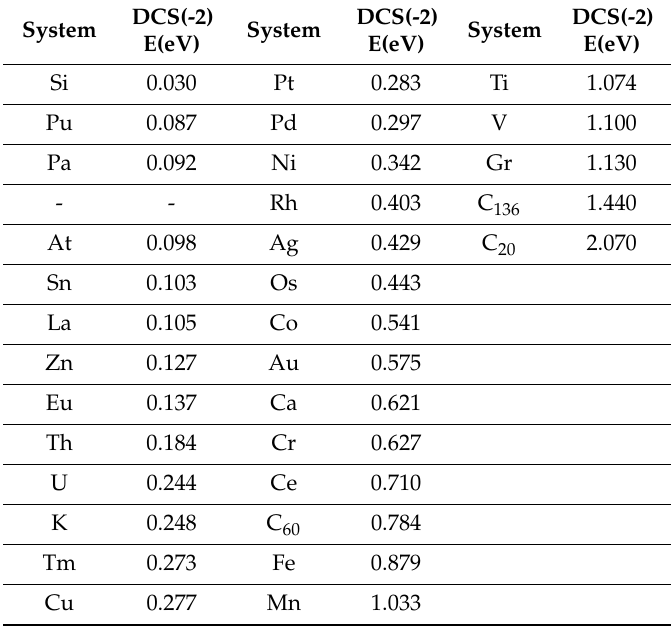
Table 1. Rank-ordered activation energy barrier reduction, E(eV), for doubly-charged negative ionic systems, DCS(-2).